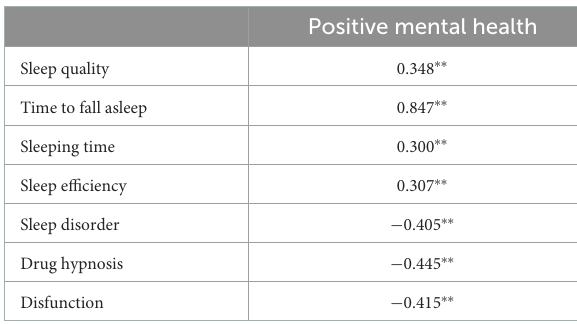
TABLE 9 Pearson correlation results of positive mental health and sleep